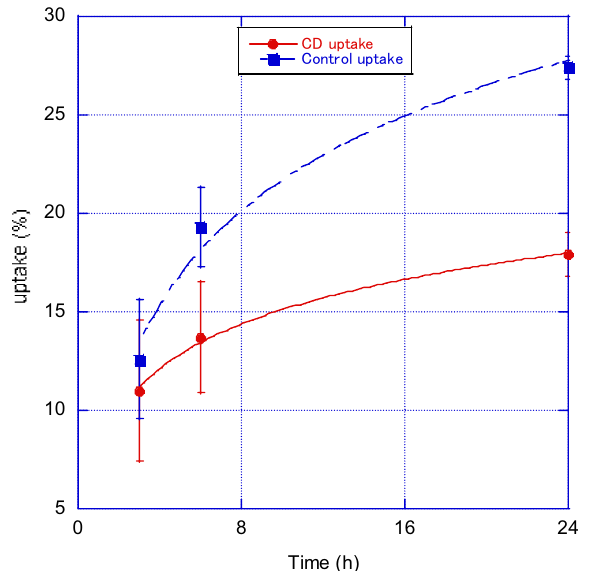
Figure 5. Temporal changes in radioactive iodine uptake rate with and without α-CD